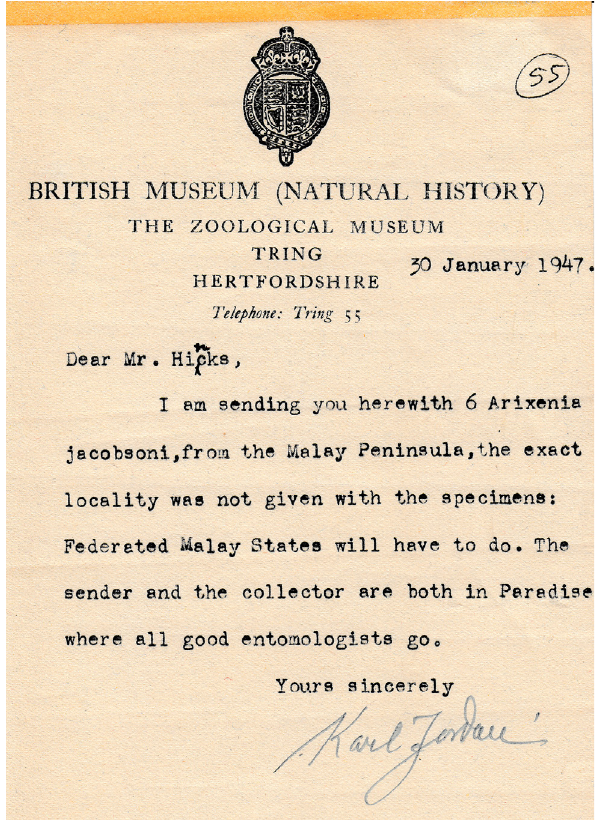
Fig. 17. Letter from Karl Jordan to Hincks enclosed with 6 ‘ Arixenia jacobsoni ’ specimens (MMUE, Brindle archive, item